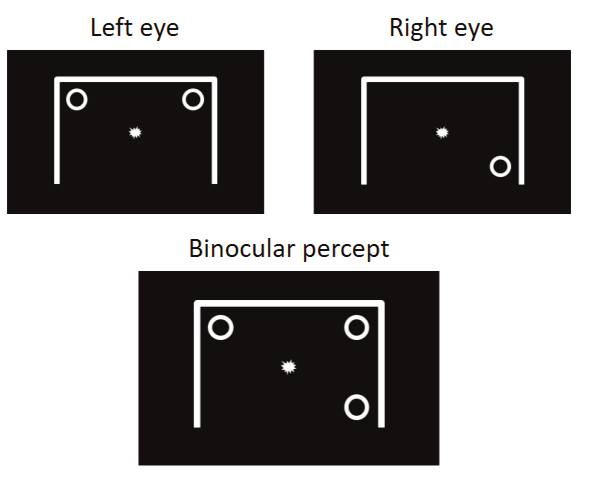
Fig. 2. Example of the demonstrated stimuli for each eye separately and the resultant binocular percept if both images were fused properly. To detect the monocular suppression, different circles were demonstrated to each eye. A circle and a rectangular arch were used to stimulate binocular